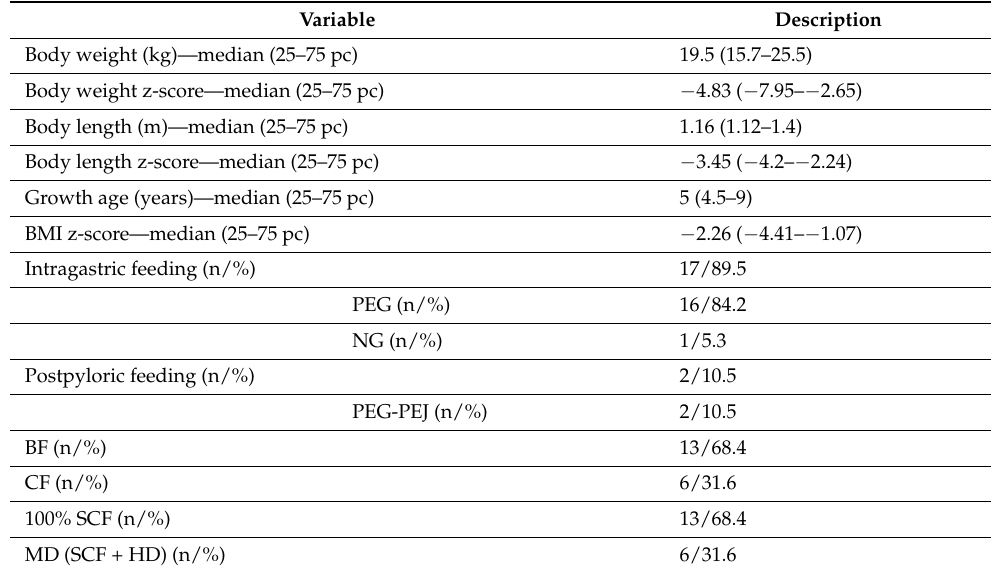
Table 1. The nutritional status and nutritional support characteristics of the study group (n =